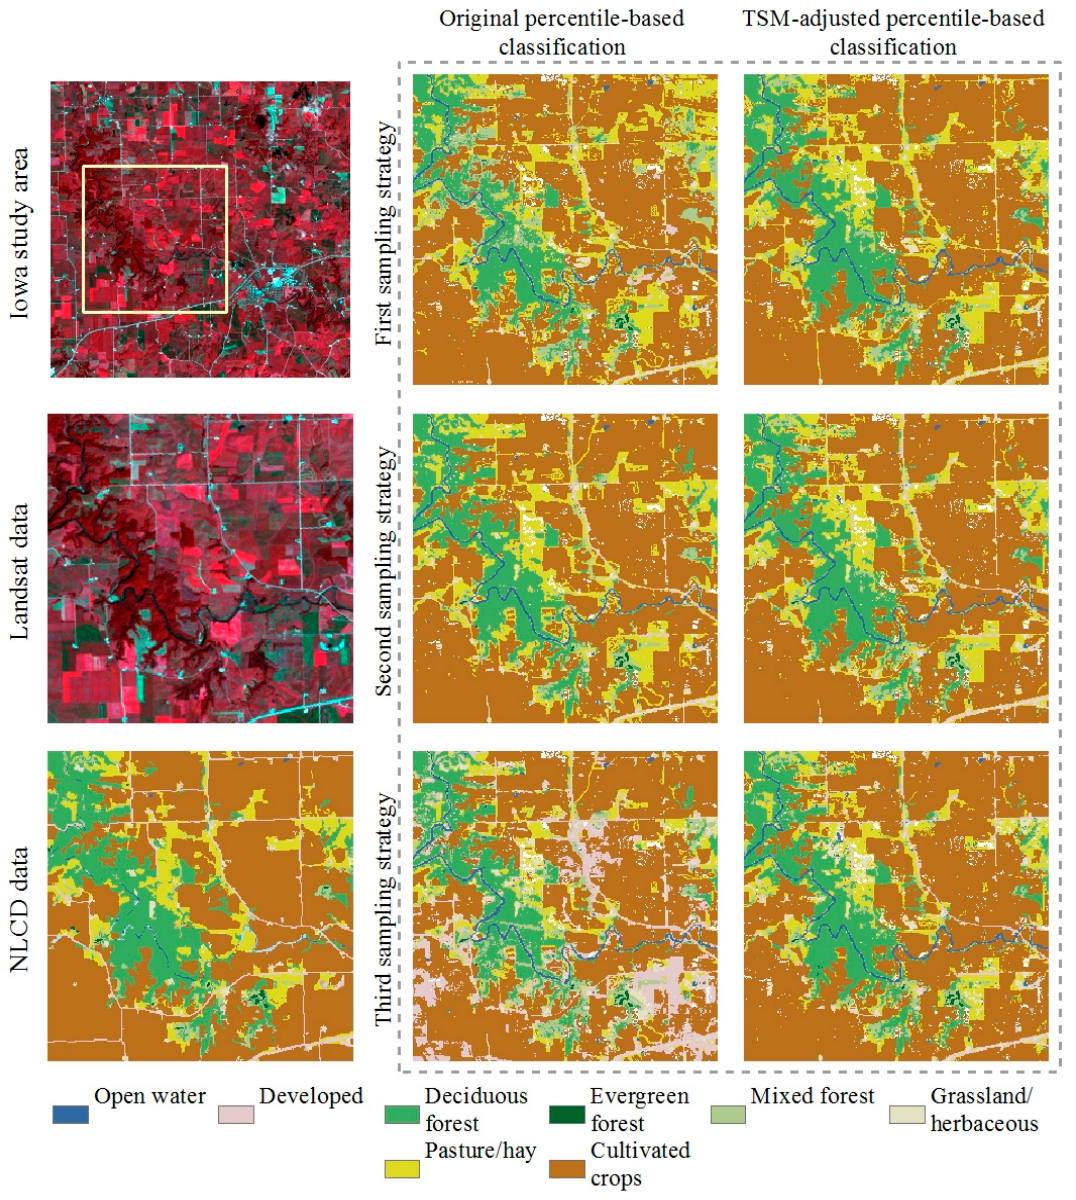
Figure 14. The close-ups of exampled Iowa study area for a spatial comparison between original percentile-based and TSM-adjusted percentile-based classification using the three sampling strategies.